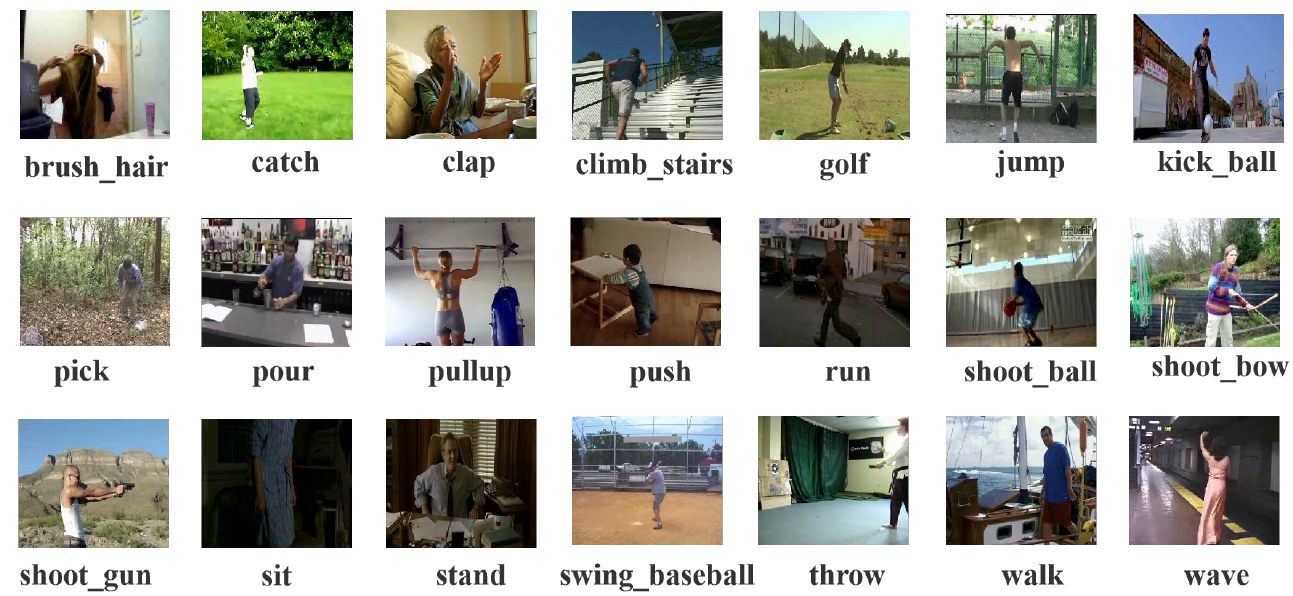
Figure 8. JHMDB dataset with a total of 21 types of actions.